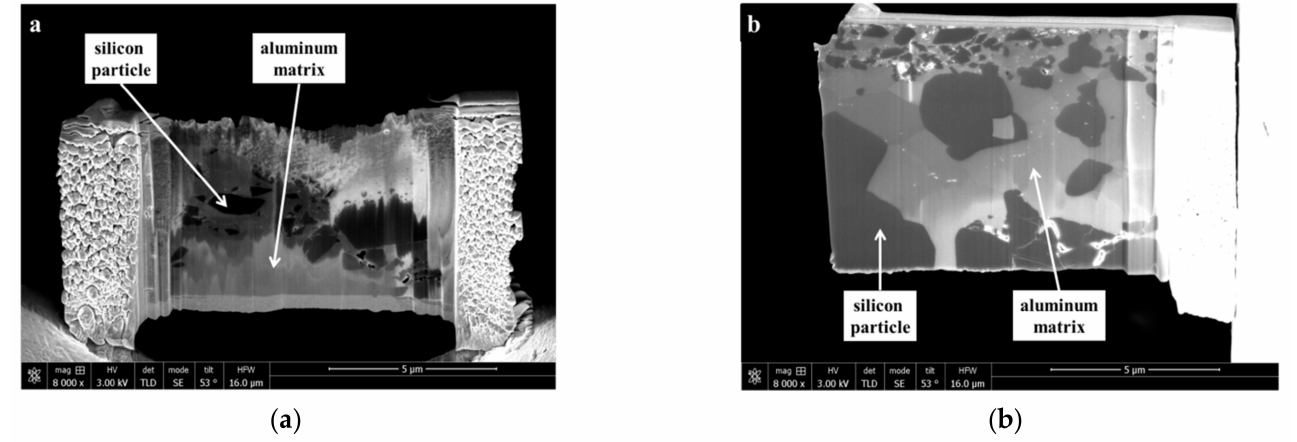
Figure 2. Scanning Electron Microscopy (SEM) secondary electron images of Al-42Si AR ( a ) and Al-42Si TT (thermally treated) ( b ). Samples were prepared by Focused Ion Beam (FIB).